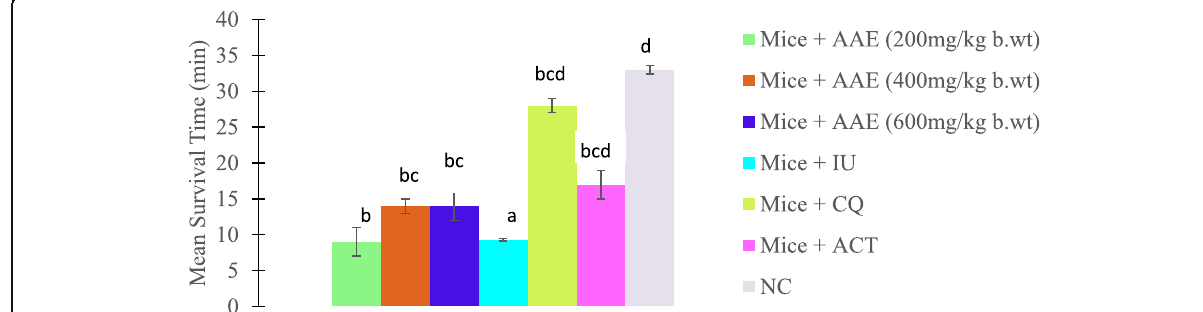
Fig. 2 Effects of aqueous extract of A. aspera on the MST level of mice infected with P. berghei (NK-65). Mice + AAE = infected mice treated with Achyranthes aspera aqueous extract, mice + IU = infected mice untreated, mice + CQ = infected mice treated with chloroquine (10 mg/kg), mice + ACT = infected mice treated with artemisinin (25 mg/kg), NC = normal control group. Values are expressed as mean ± SEM ( n = 5) values with different superscript are significantly different at p < 0.05